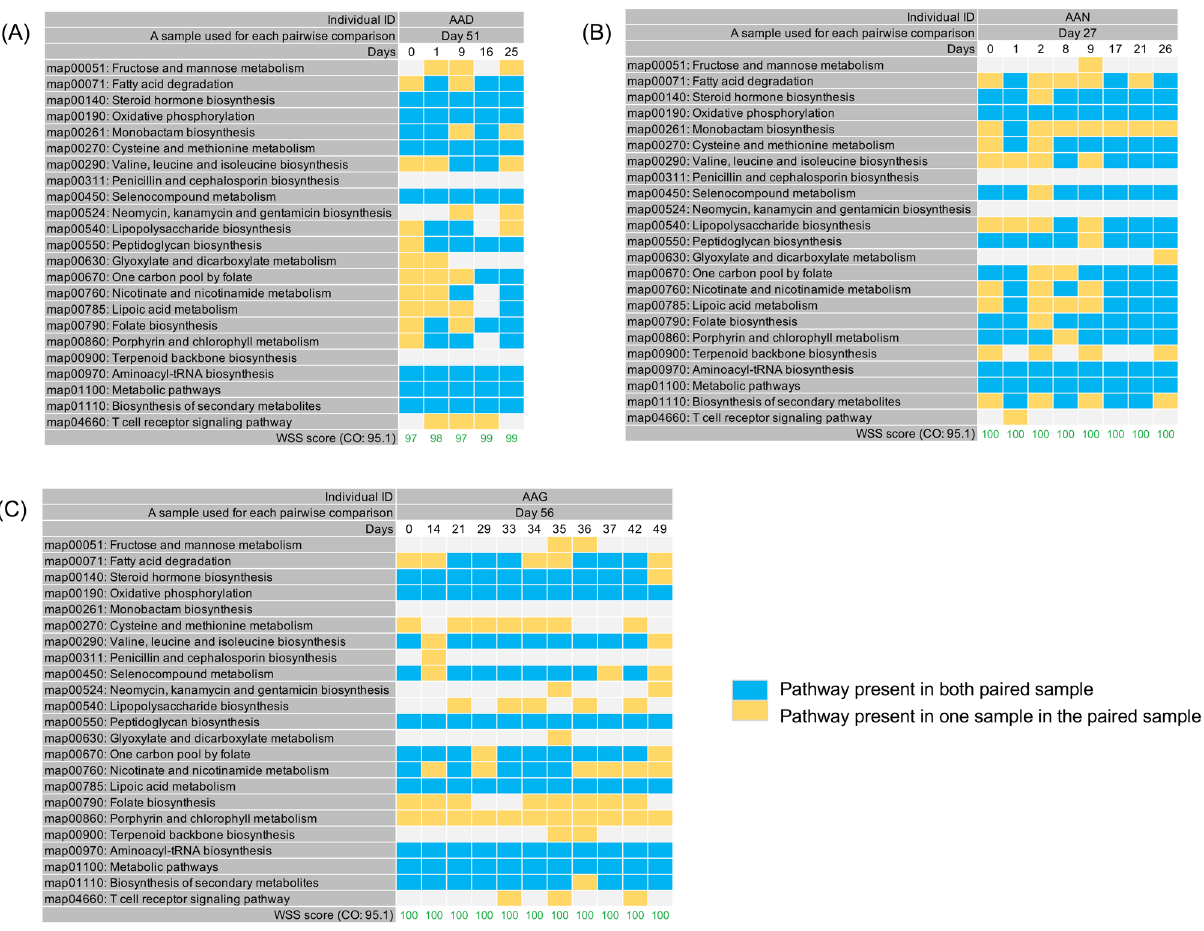
Figure 2. PKS analysis from high density sampling of healthy individuals. A total of 23 KEGG pathways were used to examine the presence/absence of KEGG metabolic pathways for B. vulgatus by comparing each individual’s last day sample to every possible pair of the same individual’s samples. The WSS scores and cut-off value for B. vulgatus are noted. All samples from the three individuals, including ( A ) AAD, ( B ) AAN, and ( C ) AAG were previously collected by Fukuyama et al. 16 . The summarized PKS result per individual was grouped into different color boxes (The color scheme for presence and absence are the same as in Fig. 1). Each column in the table represents individual ID, a sample used for each pairwise comparison, and days (Detailed sample information shown in Supplementary Table